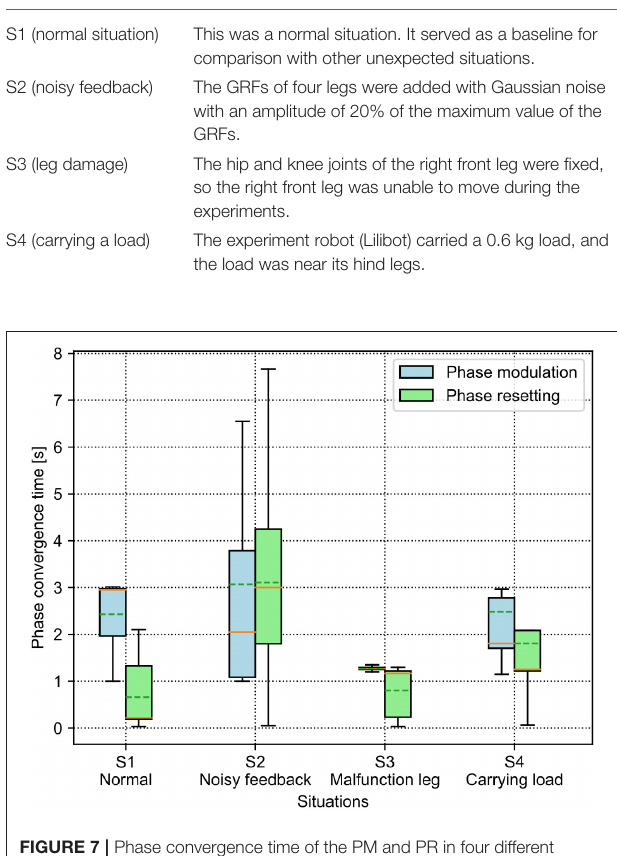
TABLE 2 | The description of the four different situations that the robot experienced in the experiments. Situations